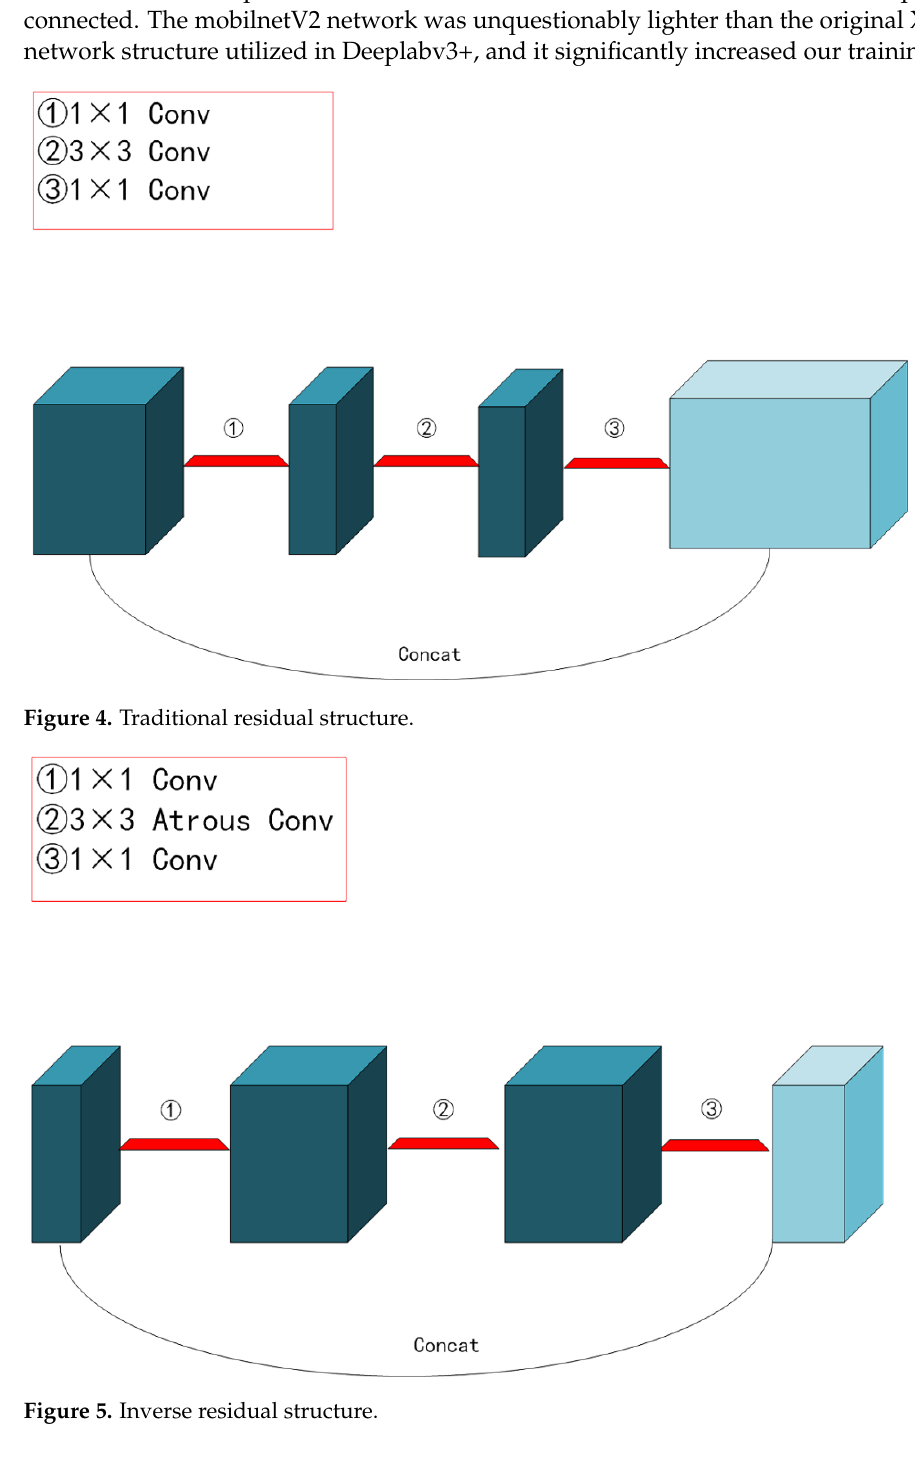
Figure 6. MobilnerV2 components. 3.1.3. Deeplabv+ Network Structure The DeepLabv3+ model [30] had been hailed as a new high point in the evolution of semantic segmentation models. It balanced high- and low-level features extracted by the backbone feature extraction network using atrous convolution, leading to a final feature map that retains the greatest range of feature information, while losing the least amount of detail information. As was noted in the preceding section, the backbone feature extrac- tion portion of the Deeplabv3+ method’s original network structure was Xception. Here, we carried out a large number of experiments and discovered that due to the particularity of the task of grass recognition, when the network structure was too deep and too large, it would increase the recognition effect of the grass, but the overfitting problem would